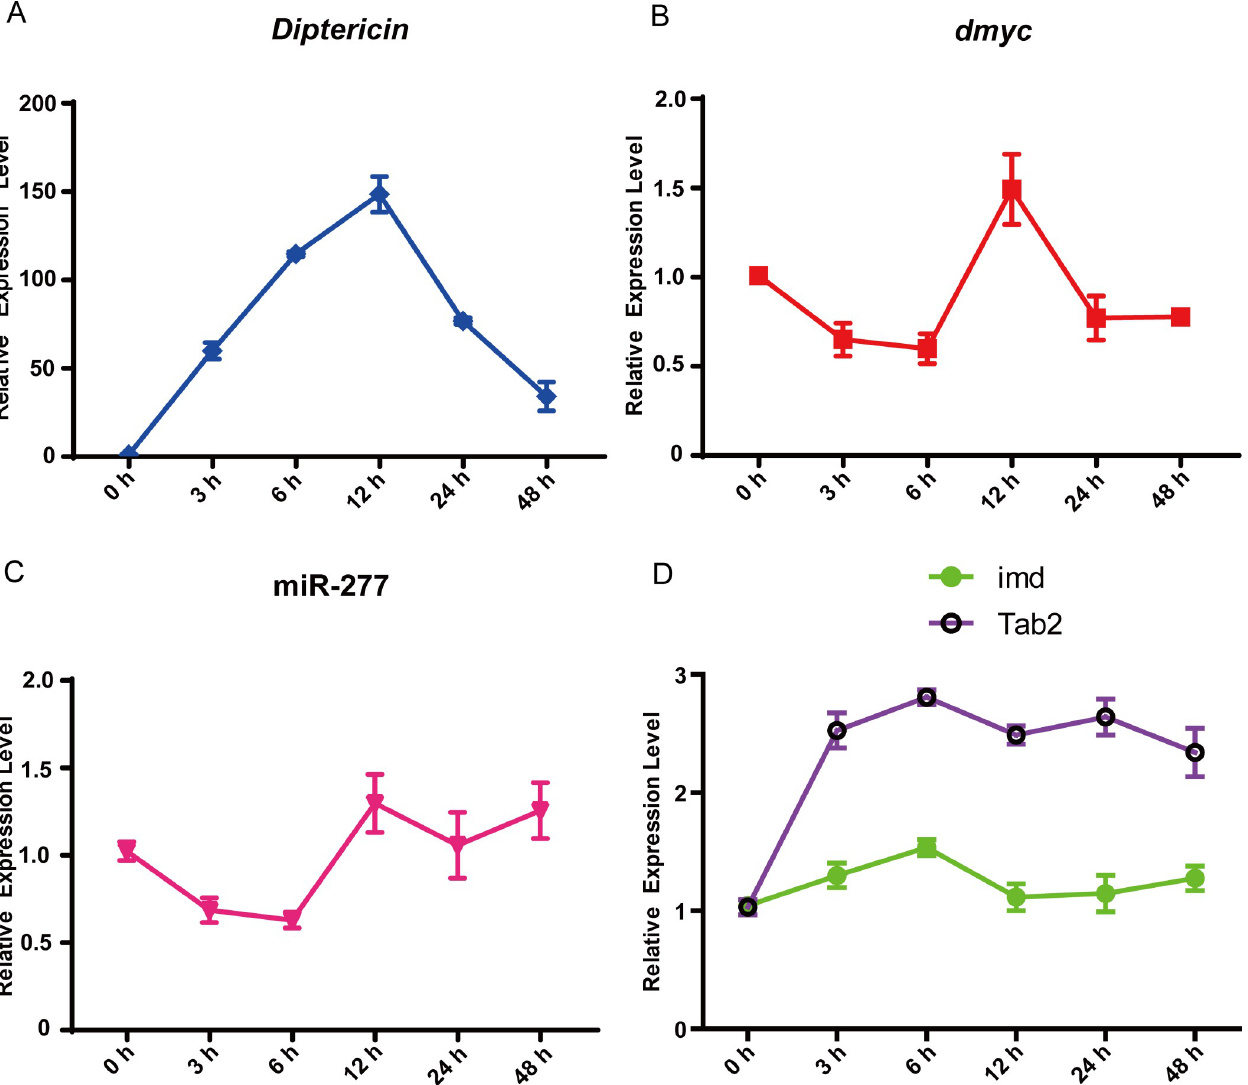
Fig 7. The temporal expression patterns of four genes and miR-277 in the wild-type flies prior to and following E . coli infection. The dynamic expression changes of Dpt (A), dmyc (B), miR-277 (C), imd and Tab2 (D) at six time-points (0, 3, 6, 12, 24 and 48 h) prior to and following E . coli infection, respectively. miRNAs were extracted from the fruit fly genome in FlyBase (http://flybase.org/) and NCBI (https://www.ncbi.nlm.nih.gov/). These relationships between mature miRNAs and 3’UTR of genes were predicted using two miRNA target prediction programs with default parameters, i.e. TargetScan (www.targetscan.org/fly_12/) [69] and miRanda v3.3a tool downloaded from microRNA.org-Targets and Expression [70, 71]. Whilst these sites of transcription factor (dMyc) binding at these promoter sequences of miRNAs were predicted through PROMO website [72, 73] and TransmiR 2.0 database (http://www.cuilab.cn/transmir). Infection and survival experiments of adult flies Three to four-day-old adult male flies were used for septic injury experiments. Control and high-expressed or knockdown gene/miRNA flies were infected by E . coli , which is a widely